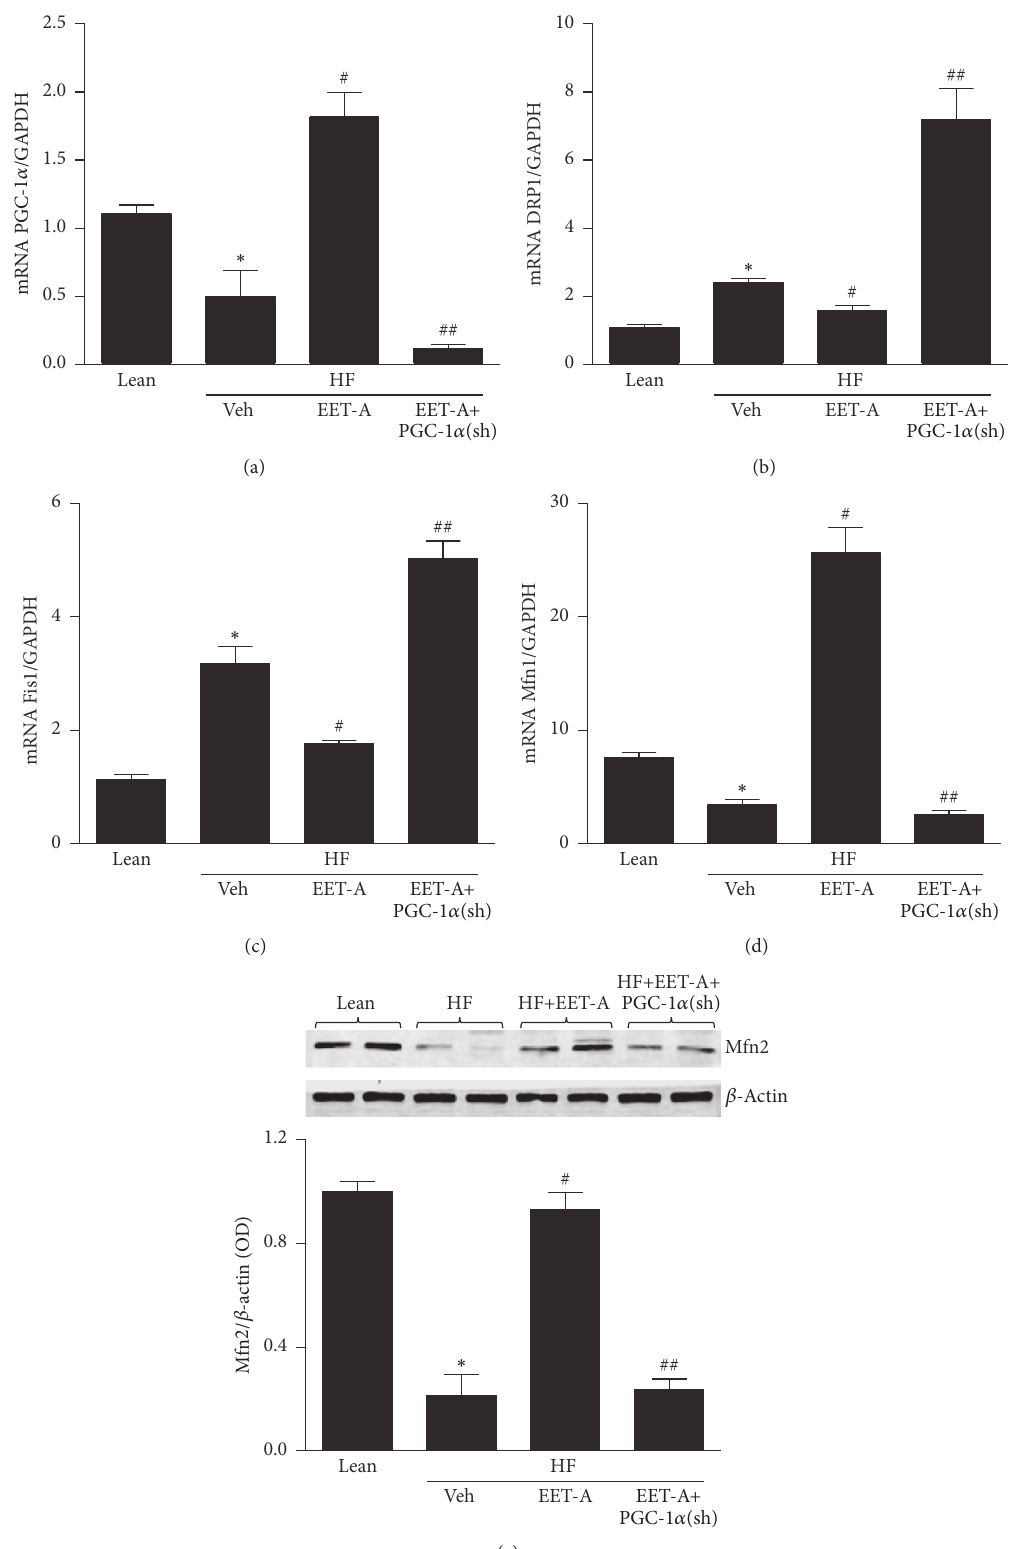
Figure 3: Effect of short-term EET-A treatment on the expression of genes related to mitochondrial biogenesis and dynamics in the adipose tissue of mice. mRNA expression of PGC-1 𝛼 (a), Drp1 (b), Fis1 (c), and Mfn1 (d) and protein expression of Mfn2 (e) in the adipose tissues of lean, HF diet fed (HF), HF diet EET-A-treated (EET-A), and PGC-1 𝛼 -deficient (Ln shPGC-1 𝛼 ) mice. Results are mean ± SE, 𝑛 = 3-4, ∗ 𝑝 < 0.05 versus lean, # 𝑝 < 0.05 versus HF, and ## 𝑝 < 0.05 versus